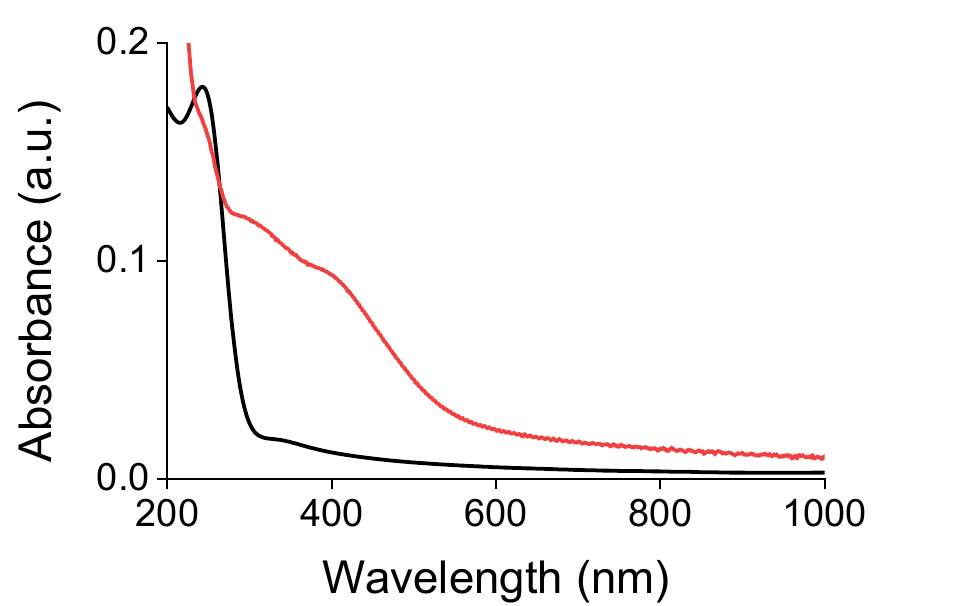
Figure 7. UV-Vis spectrum of the ProDOT-Poly(MM) (black line) and Poly(ProDOT)-Poly(MM) (red line) brush grafted from quartz.